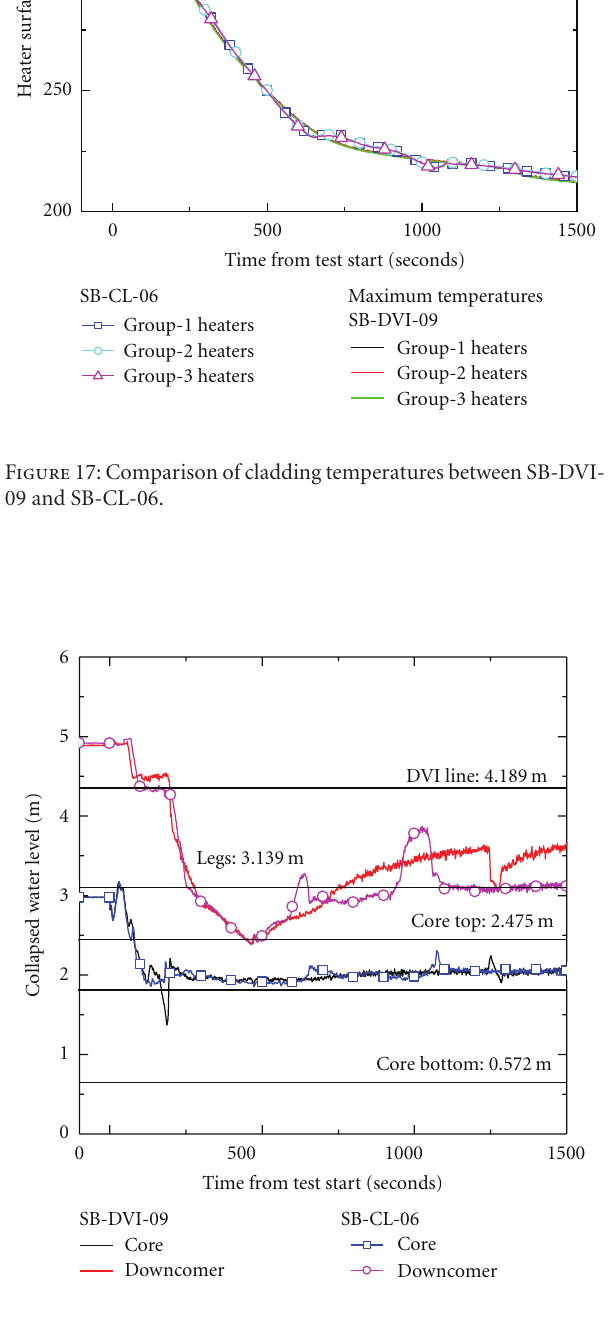
Figure 18: Comparison of the water levels between SB-DVI-09 and SB-CL-06.